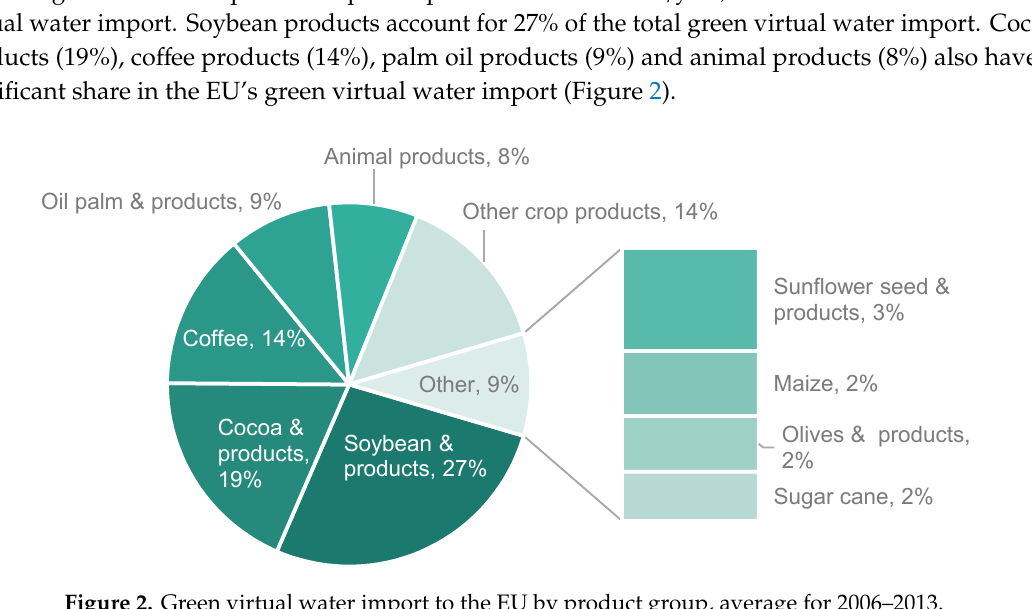
Table 1. Vulnerability levels and corresponding drought severity index and blue water scarcity category.